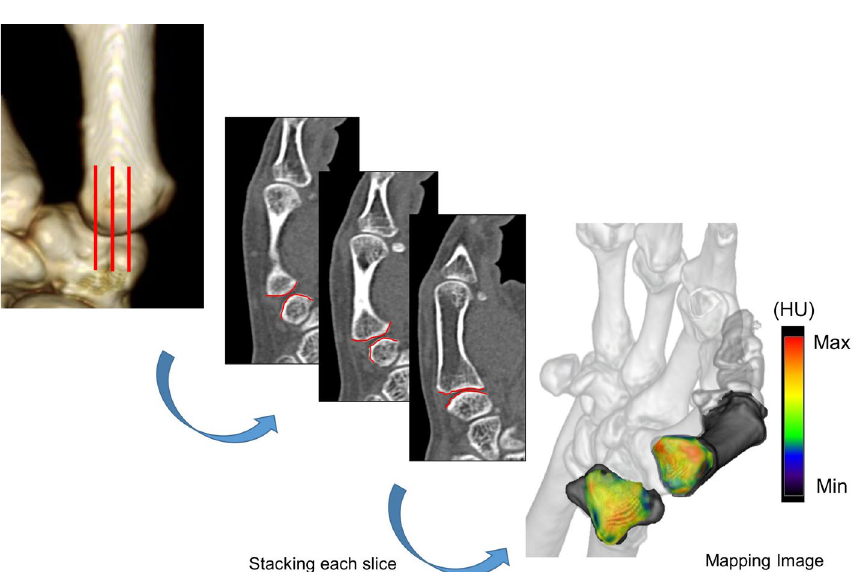
Figure 2. Identification of subchondral bone regions for articular surfaces of the trapezium and first metacarpal using customized software. In each sagittal slice, X-ray attenuation (in Hounsfield units) is measured in subchondral bone at each coordinate point within a 1-mm interval, and the distribution pattern in the subchondral bone is represented as a surface-mapping